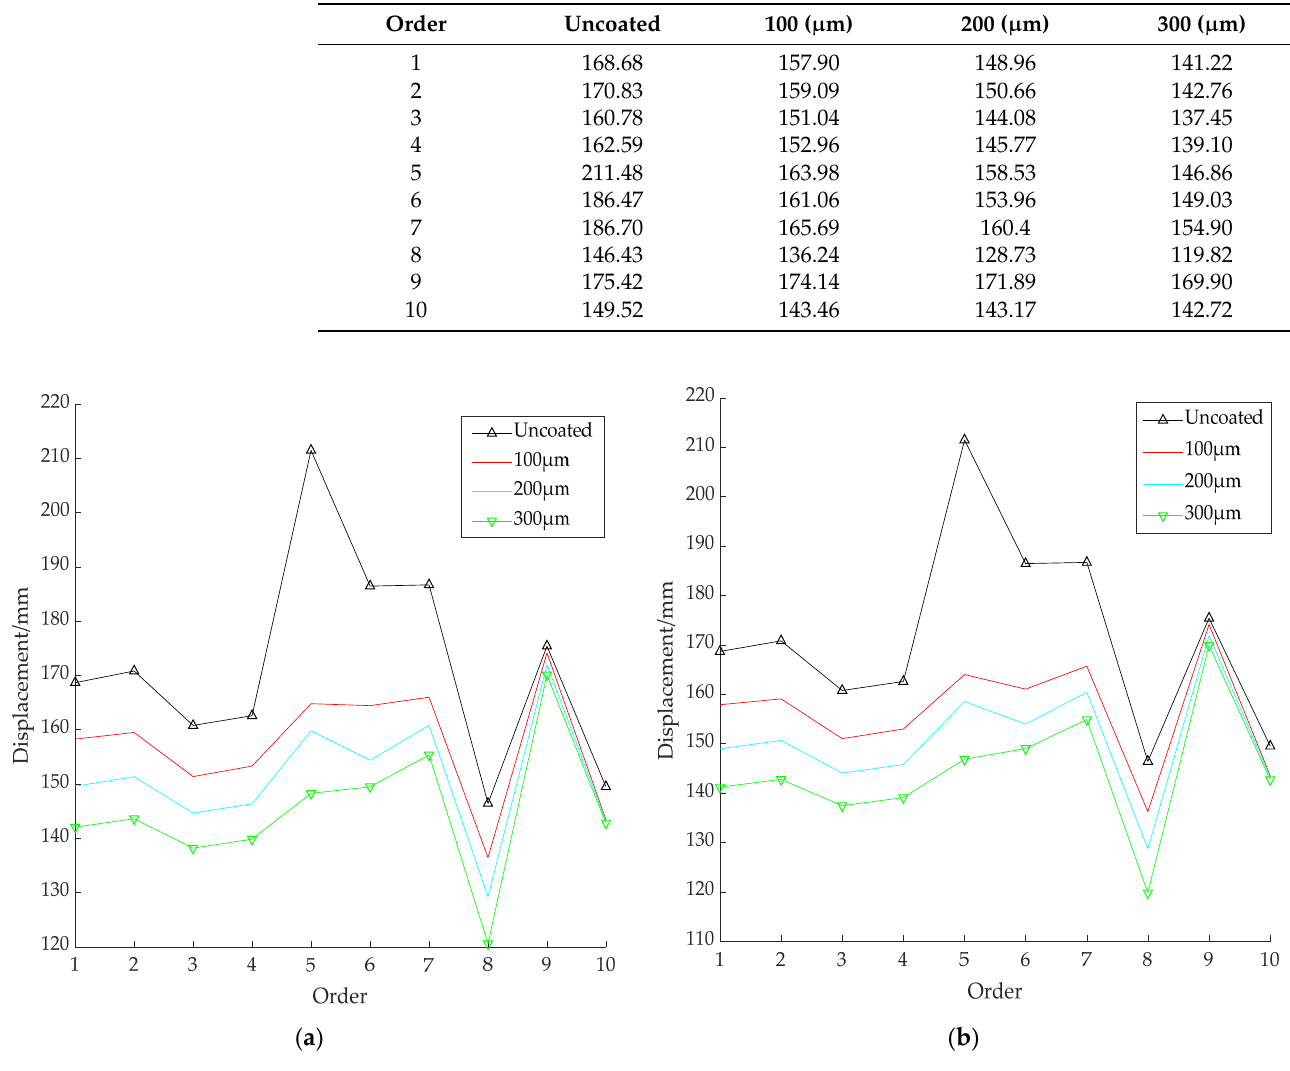
Figure 6. Maximum deformation of the main vibration mode of the TA18 titanium alloy straight aviation hydraulic pipe coated with different thicknesses: ( a ) with the YSZ coating; ( b ) with the YSZ–PTFE coating. Table 6. Natural frequency (Hz) of the TA18 titanium alloy straight aviation hydraulic pipe coated with the YSZ–PTFE coating at different coating thicknesses.